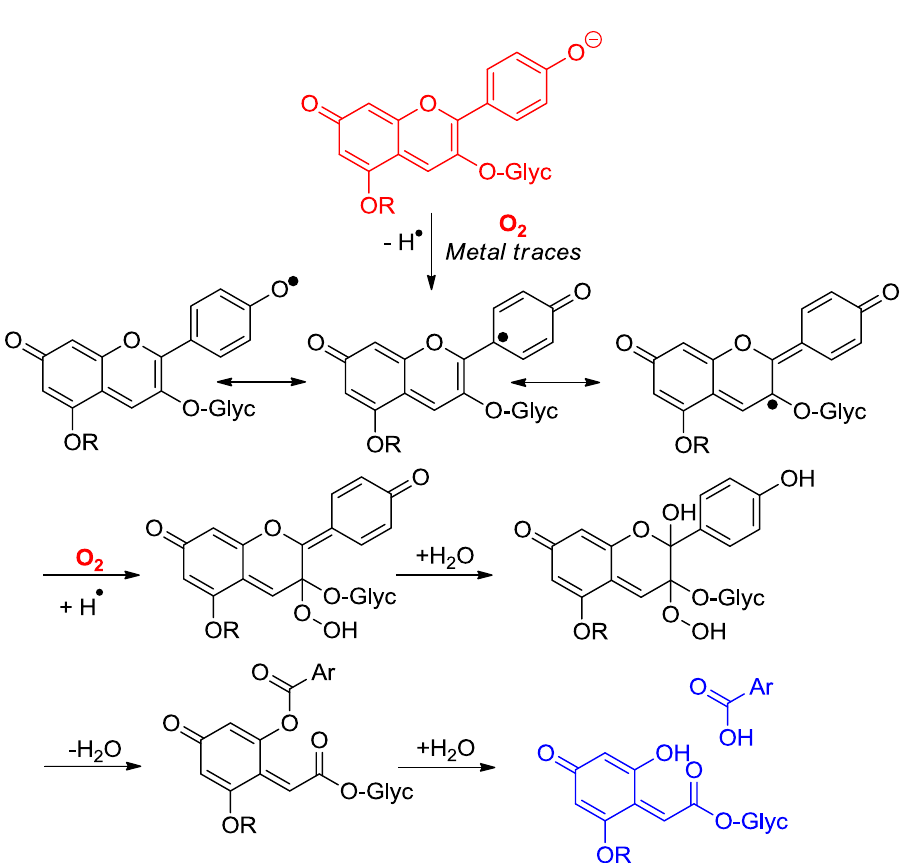
Figure 10. Possible mechanisms of anthocyanin degradation without pre-formed hydrogen peroxide.